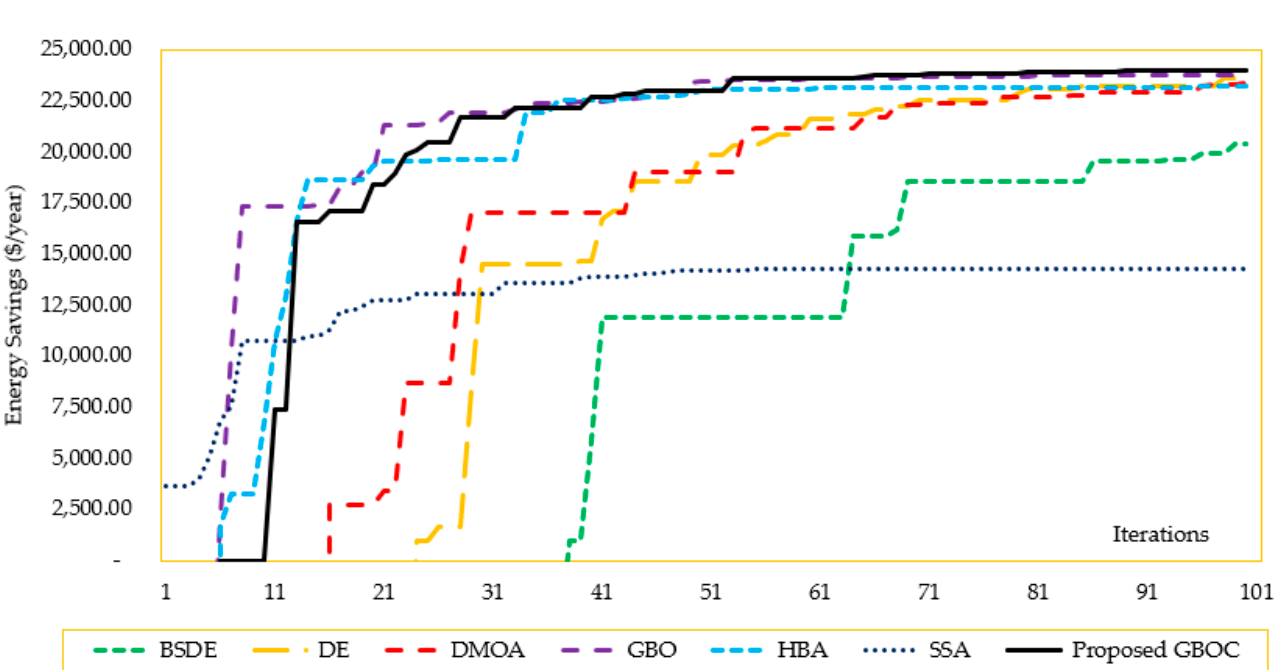
Figure 7. Convergence characteristics of GBOC, GBO, SSA, DMOA, DE, and HBA for the IEEE 33-distribution system for Scenario 2.